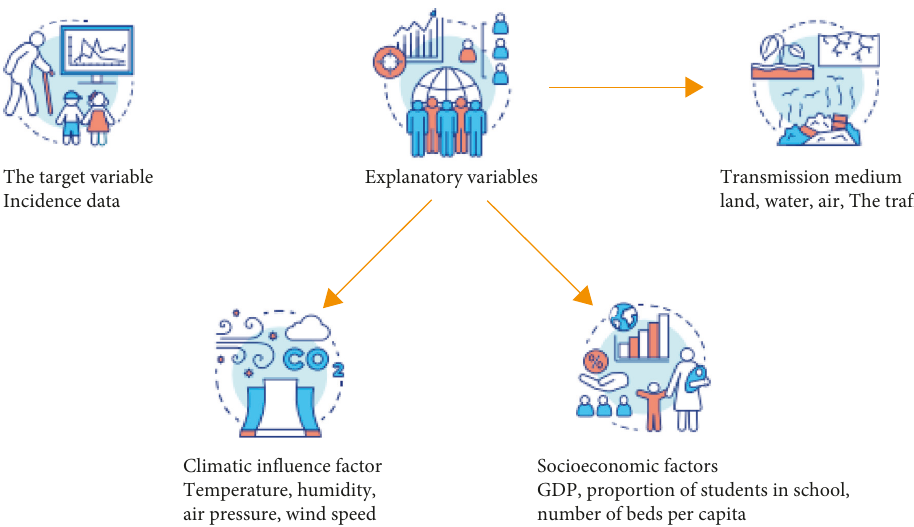
Figure 1: Human health risks of regional atmospheric environmental pollution